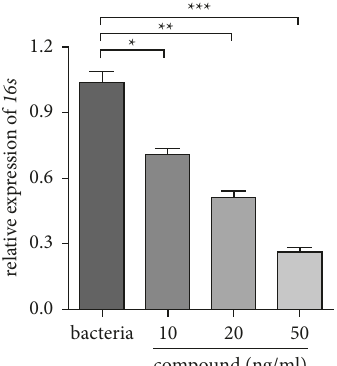
Figure 6: Evidently suppressed expression of bacterial survival gene by the treatment of compound. The bacterial were treated through the compound with specific concentrations, the bacterial survival genes relative expression were tested through utilizing real time